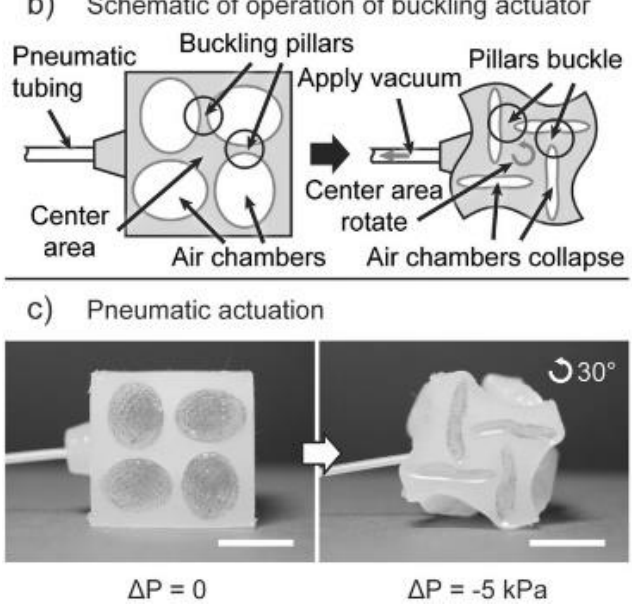
Figure 5. Schematics of a pneumatic buckling actuator. ( a ) actuator structure, ( b ) actuator operation, ( c ) pneumatic actuation [73].